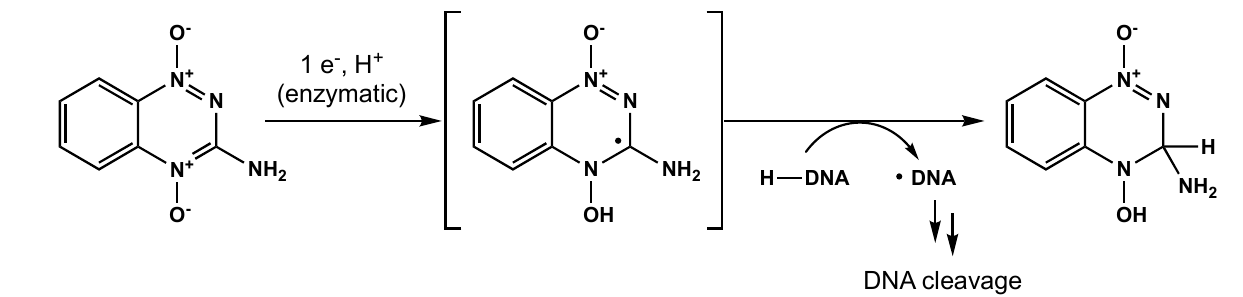
Figure 5. One proposed mechanism for tirapazamine-mediated DNA cleavage under hypoxic con- ditions.